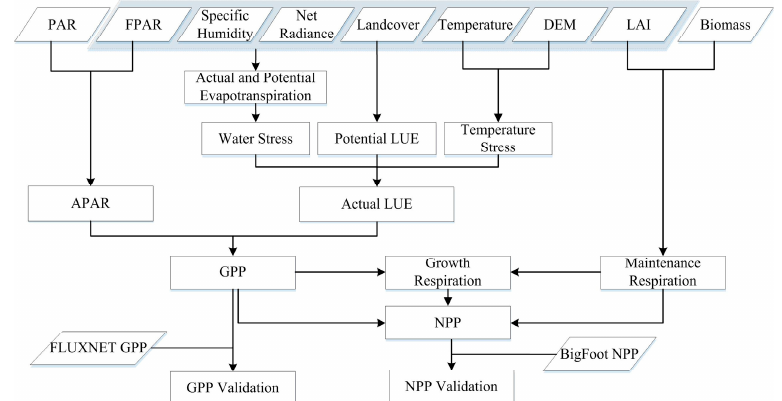
Figure 1. Flowchart of gross primary production (GPP) and net primary production (NPP) estimation and validation. FPAR: Fraction of Photosynthetically Active Radiation; LAI: Leaf Area Index; LUE: Light Use Efficiency; PAR: Photosynthetically Active Radiation; APAR: Absorbed Photosynthetically Active Radiation; DEM: Digital Elevation Model.